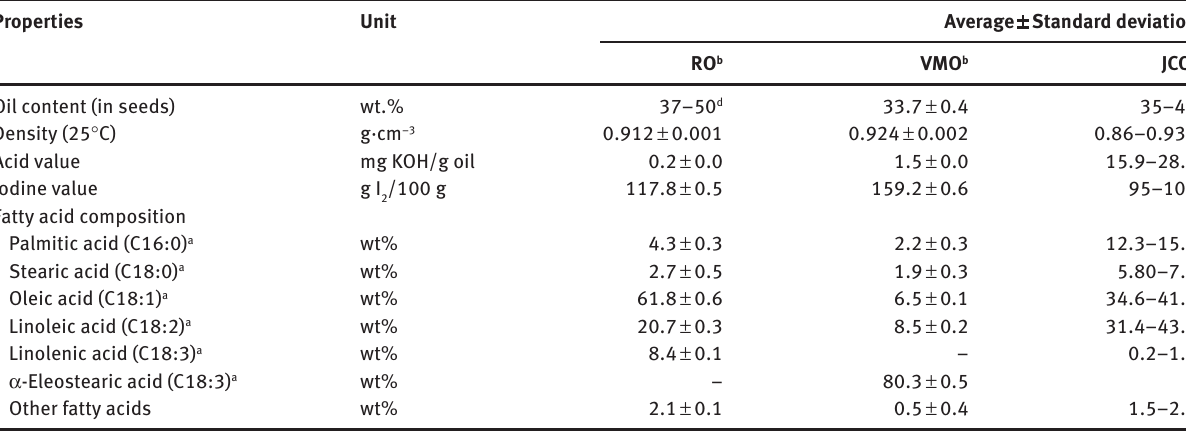
Table 1: Chemical and physical properties of RO, VMO and JCO used in this